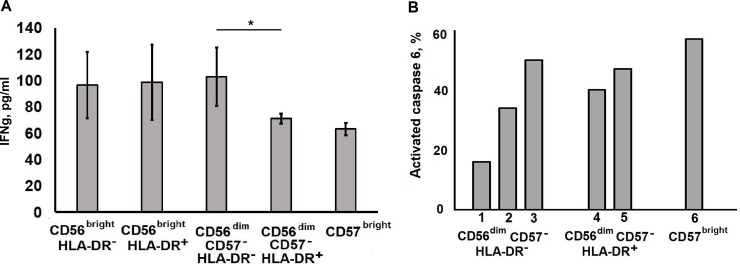
Functional activity of NK cell clones.(A) IFN-γ production was analyzed by ELISA in 25 clones from one collection: 4 for CD56brightHLA-DR–, 4 for CD56brightHLA-DR+, 4 for CD56dimCD57–HLA-DR–, 9 for CD56dimCD57–HLA-DR+, and 4 for CD56dimCD57brigh cells. (B) Natural cytotoxic activity of clones derived from different NK cell subsets.